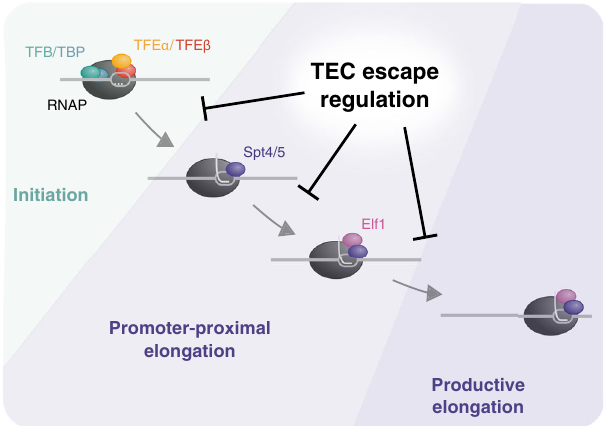
Fig. 7 A model for the promoter-proximal elongation phase. Schematic overview of the promoter-proximal elongation phase and the effect of TEC escape regulation on individual steps leading towards productive transcription. Low TEC escape is associated with the accumulation of PICs and the two different TEC intermediates TEC Spt4/5 and TEC Spt4/5-Elf1